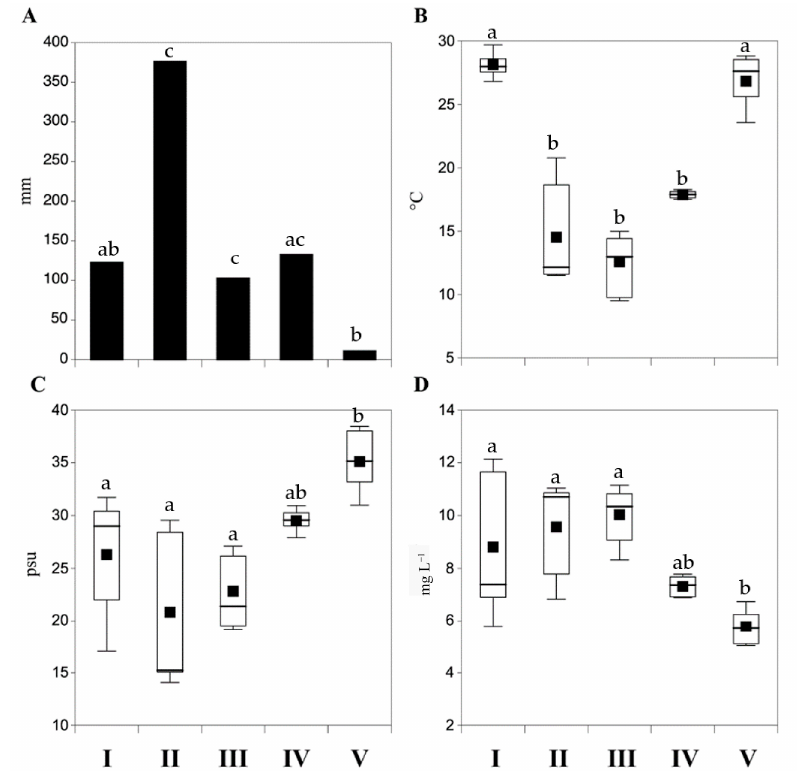
Figure 2. Seasonal dynamics of rainfall accumulation (Rain) ( A ), and boxplots depicting seasonality of water temperature (Temp) ( B ), salinity (Sal) ( C ), and dissolved oxygen (DO) ( D ) in Santa Giusta Lagoon along the study periods. Five periods were considered: Summer 2018 (I), Autumn (II), Winter (III), Spring (IV) and Summer 2019 (V). Boxplots include the entire series of data for each season. Lines represent medians; squares represent means. Bottom of box is the first quartile (Q1); upper part is the third quartile (Q3). Whiskers represent the 90th and 10th percentiles. Different letters indicate significant differences among periods ( p < 0.05).